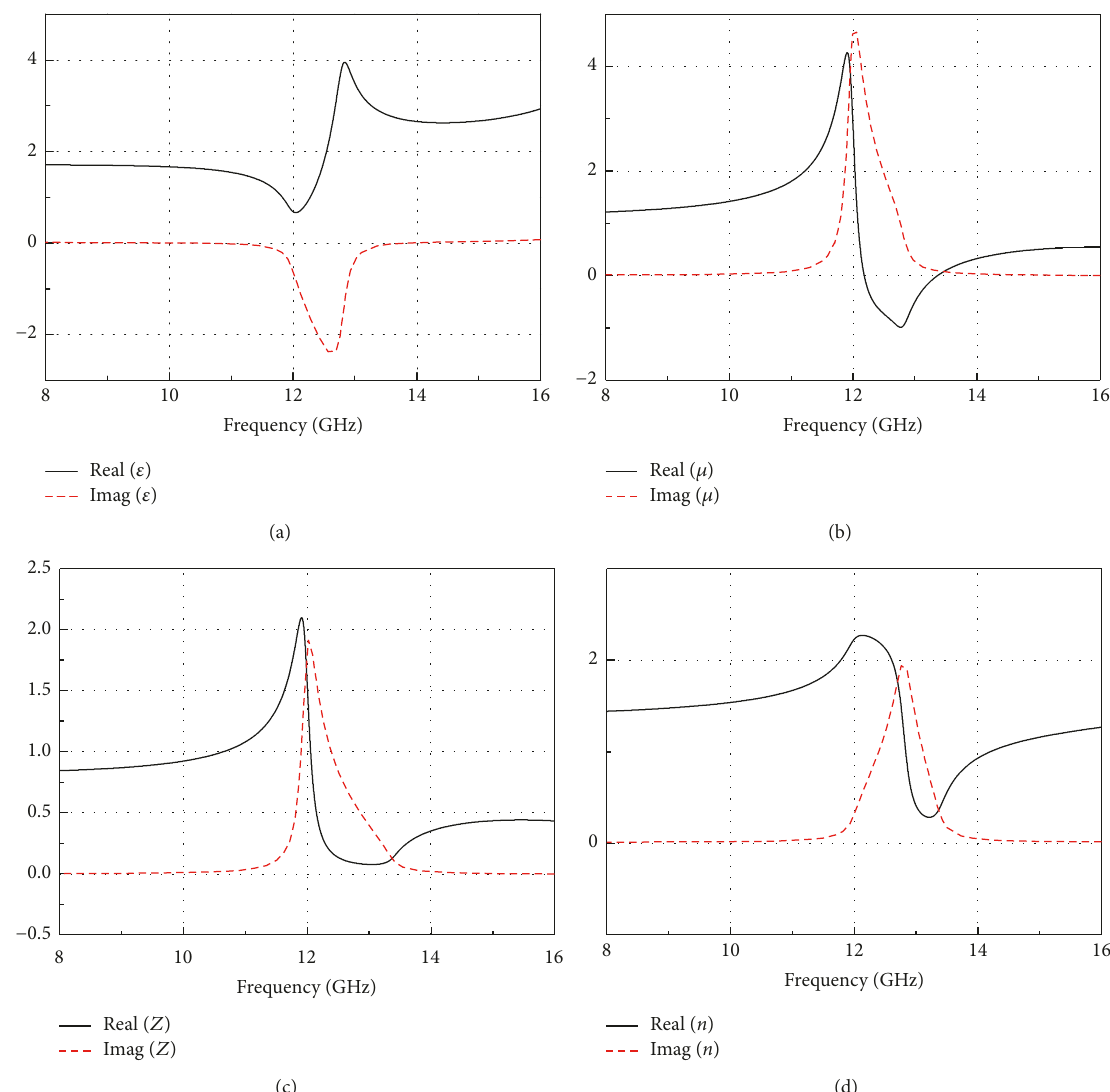
Figure 4: Retrieved effective (a) permittivity “ 𝜀 ,” (b) permeability “ 𝜇 ,” (c) impedance “ 𝑍 ,” and (d) refractive index “ 𝑛 .” The black solid lines refer to the real part of these parameters, while the red dashed lines refer to the imaginary